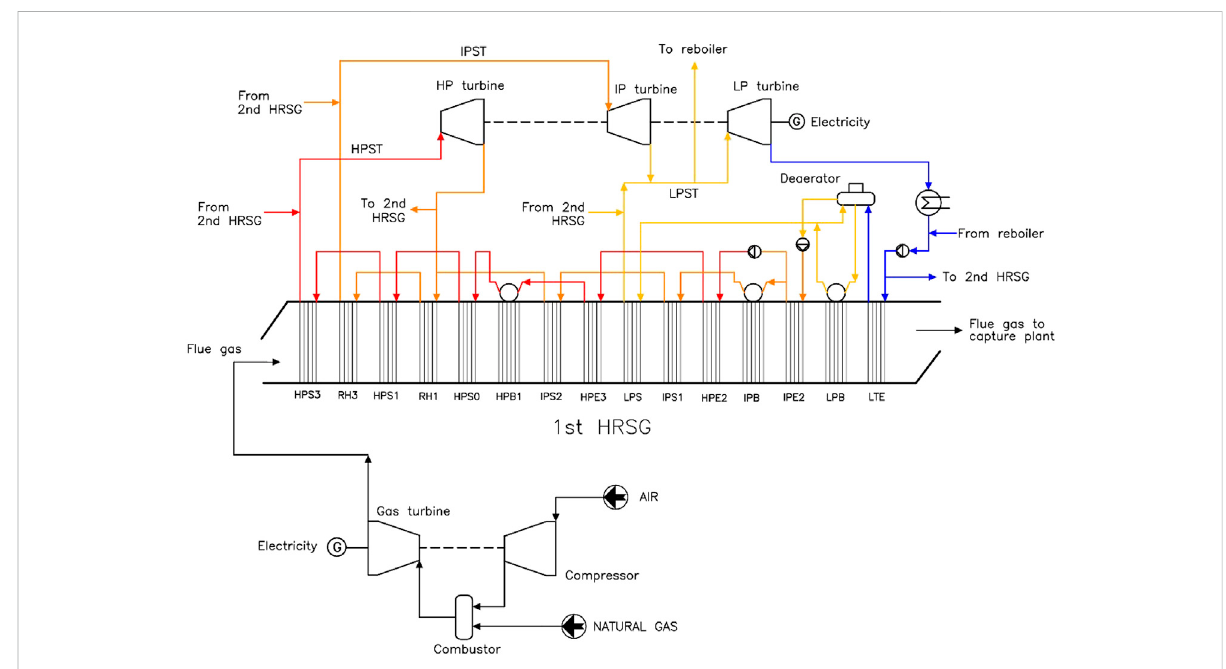
FIGURE 1 Conventional case: Natural gas combined cycle. Extracted from (Díaz-Herrera et al., 2020).